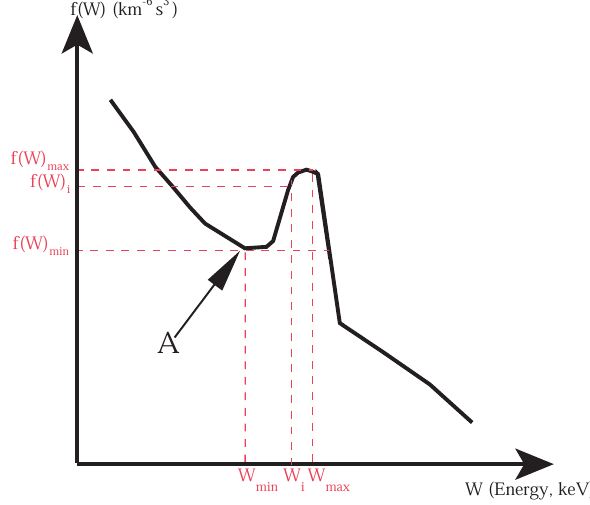
Figure 1. Fig. 1. Schematic indicating how the free energy contained in the positive gradient region is calculated. The point A represents the lo- cation in phase space where the particles which contain free energy are transposed